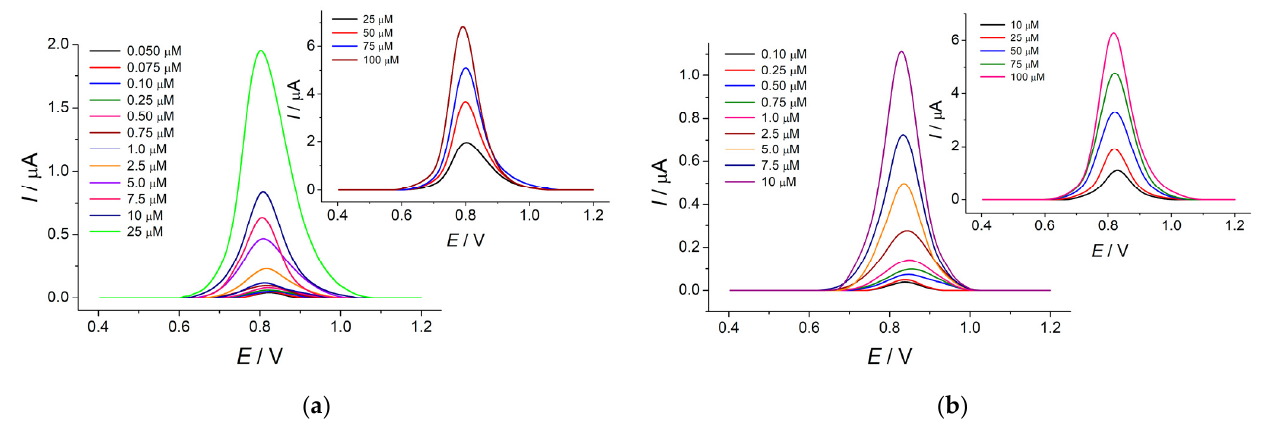
Figure 10. Baseline-corrected DPVs of isopropylmethylphenols at various concentrations at the polythymolphthalein/MWCNTs/GCE in Bri tt on–Robinson bu ff er pH 2.0: ( a ) thymol; ( b ) carvacrol. Δ E mod = 100 mV, t mod = 25 ms, υ = 20 mV s − 1 .